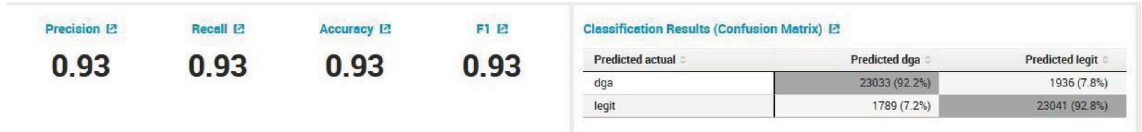
Figure 14: Value evaluation results based on logistic regression algorithm using principal component analysis feature.